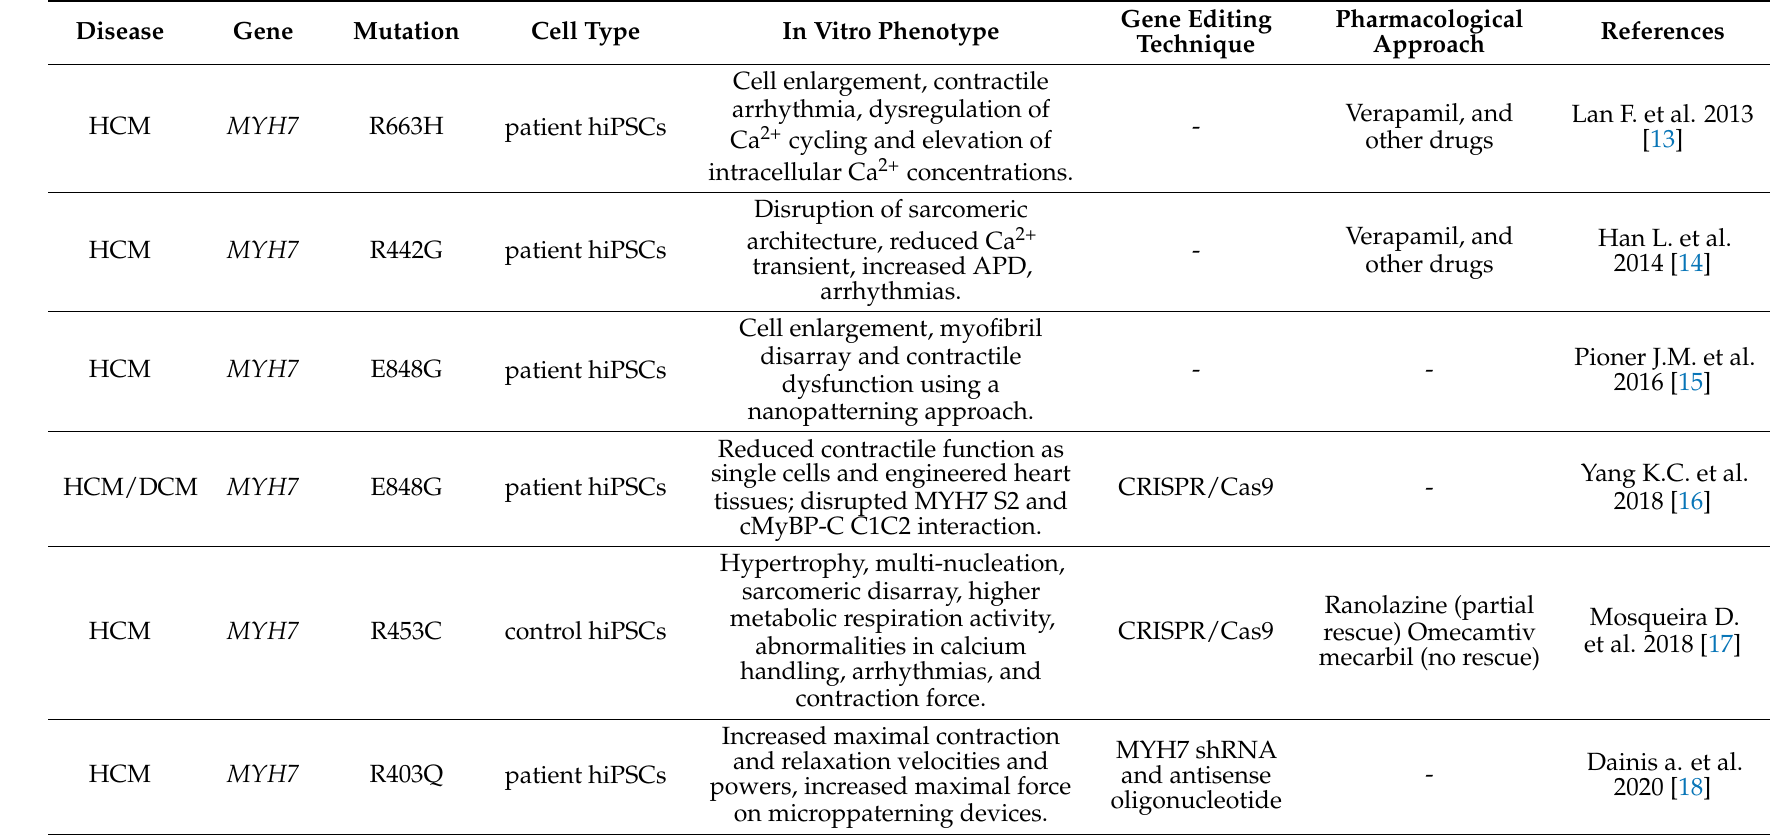
Table 1. List of hiPSC-based genetic cardiomyopathies models and main